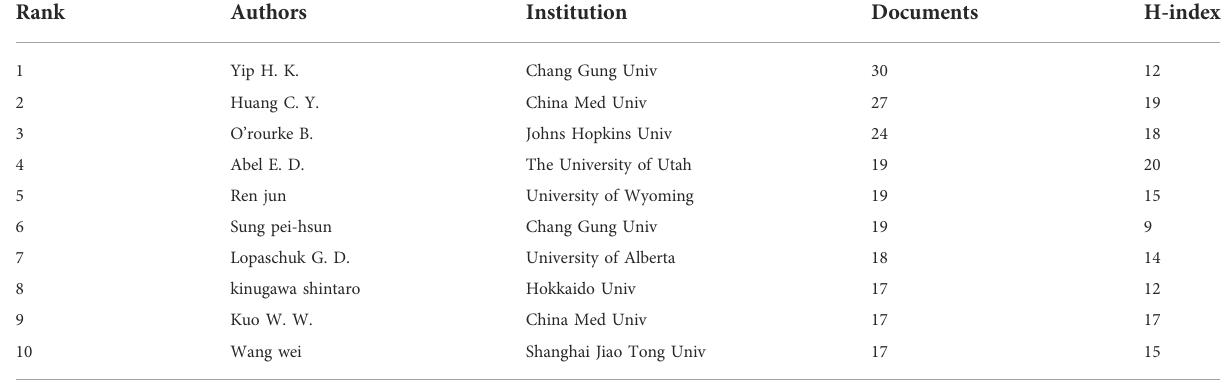
TABLE 3 Top 10 authors in the fi eld of mitochondrial function and heart failure.